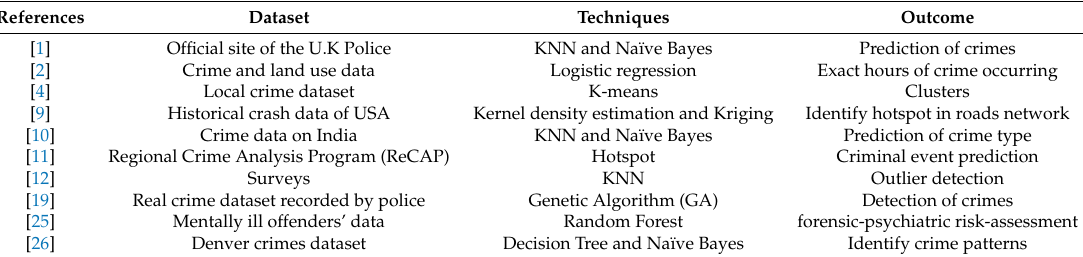
Table 1. Summery of the state-of-the-art works.